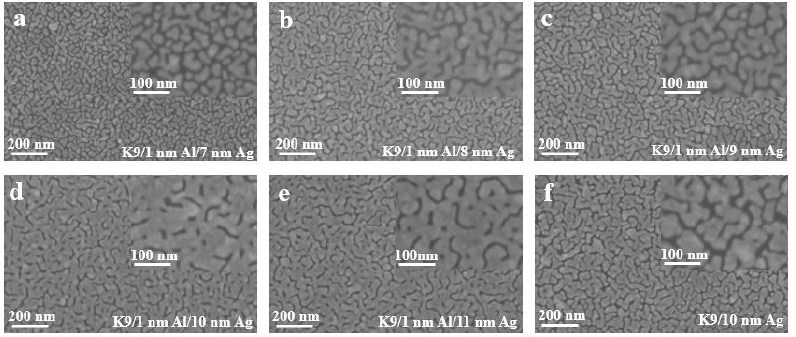
Figure 7. ( a – e ) SEM images of silver film with different thickness on the surface of a 1 nm aluminum seed layer. ( f ) SEM images of silver film with 10 nm on K9 substrate.